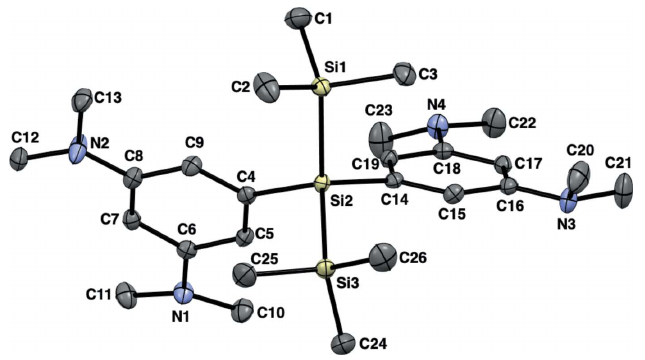
Figure 2 A packing diagram of the title compound, emphasizing the inter- molecular SiC—H (cid:3)(cid:3)(cid:3) (cid:2) (aryl) interactions (light-blue dotted lines). [Symmetry code: (i) x , (cid:5) y + 1 , z + 1 2 2